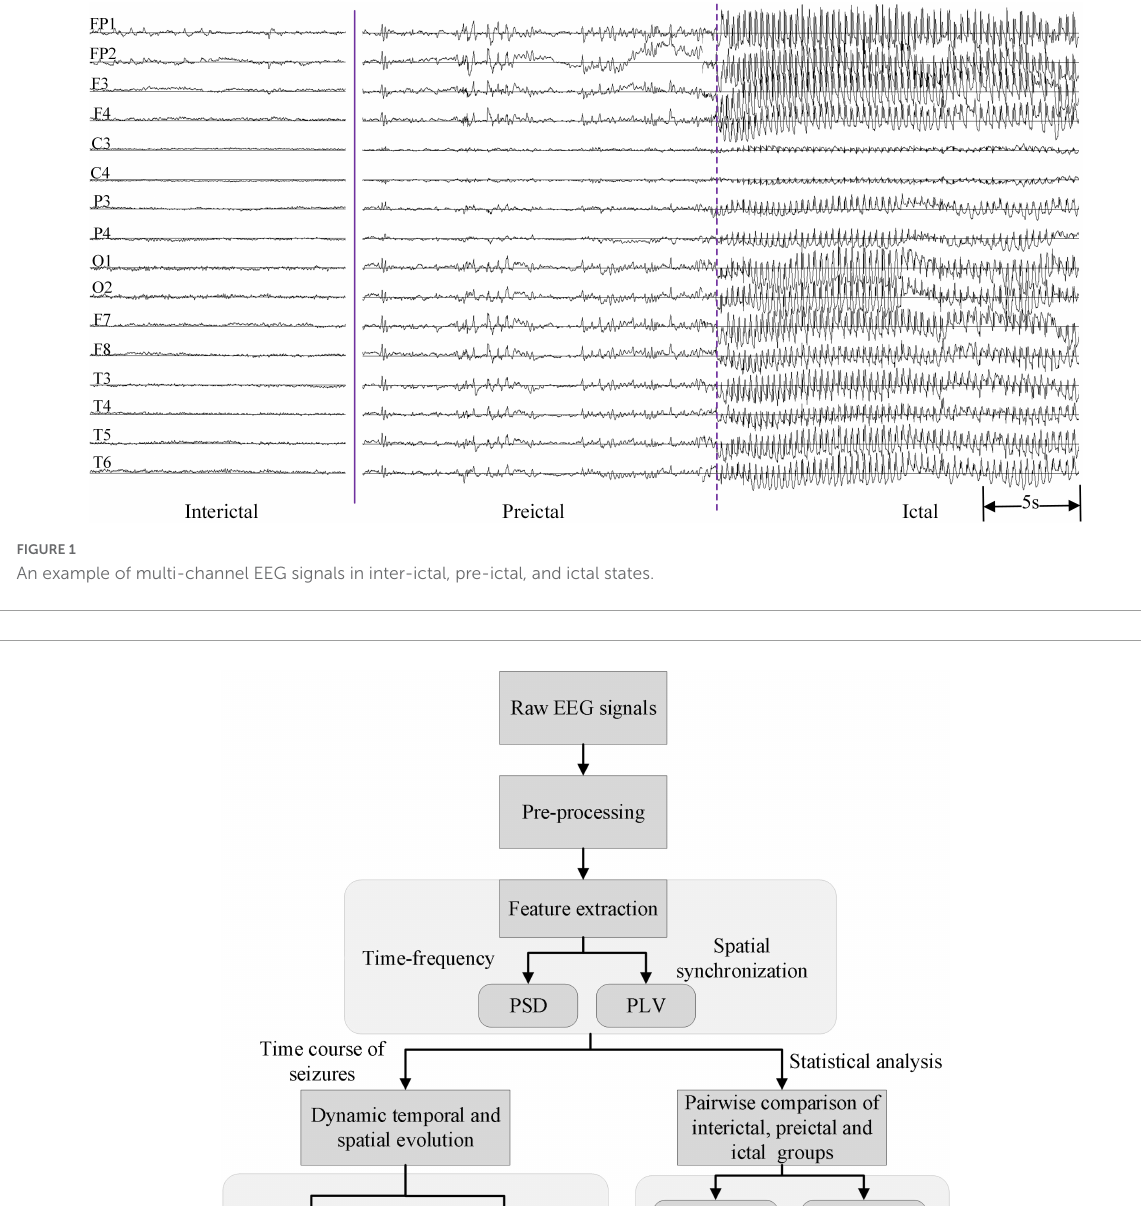
in this sample tends to decrease gradually during this seizure ( Figure 3A ). Still, there is a process of first increasing and then decreasing in the spatial distribution, indicating that the evolution of power and distribution is inconsistent. For a